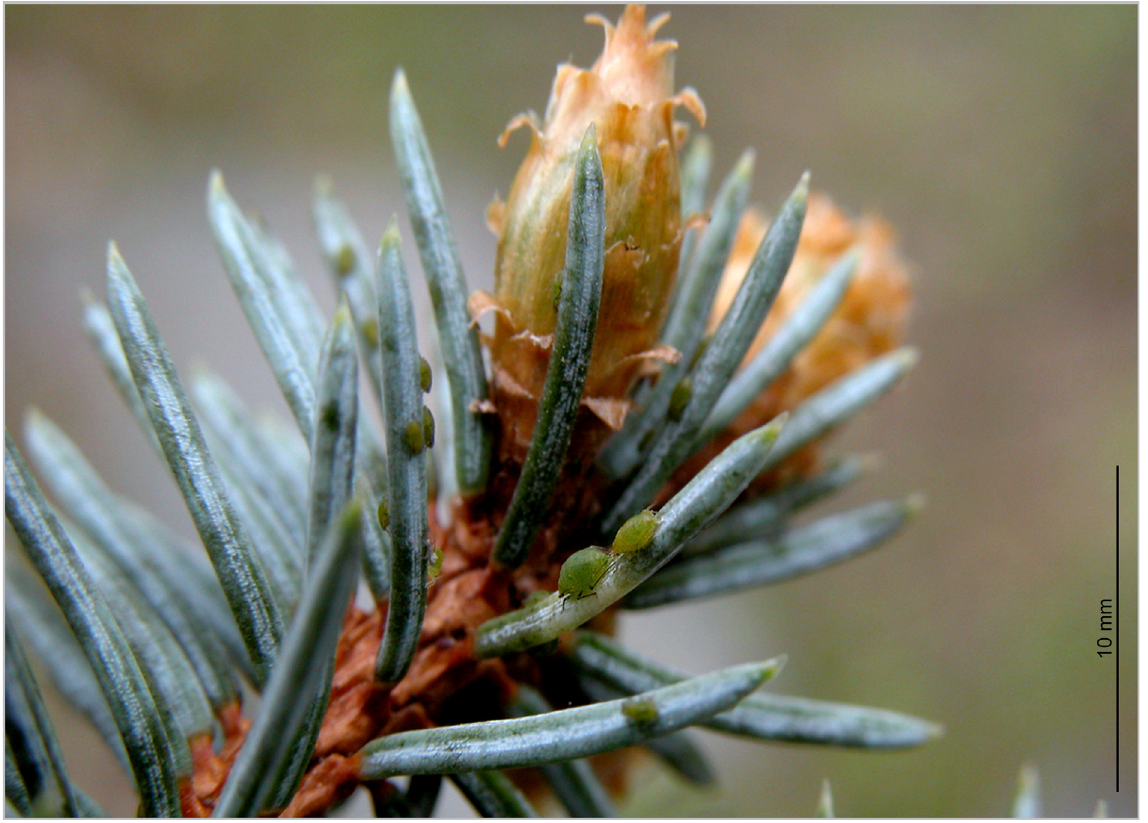
Fig. 24. Elatobium abietinum (Walker, 1849). Colony on needles of Picea pungens